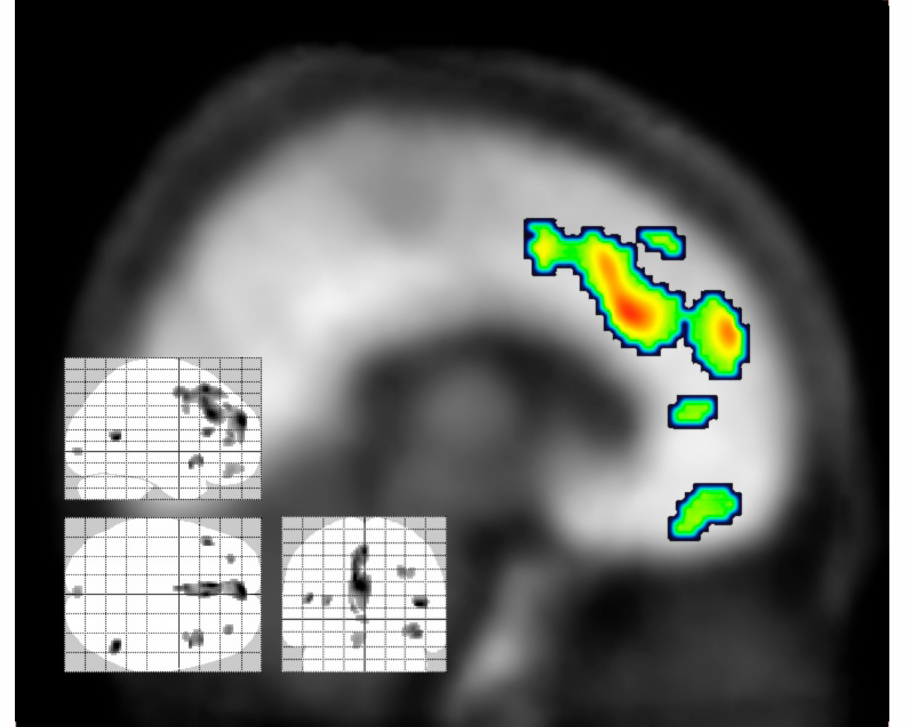
Figure 6. Inverse Correlation of 5D-ASC Global Scale scores and [ 18 F]-altanserin ( 39 ) apparent distribu- tion volume [DV’]. Results of a voxel based correlation analysis ( ∆ 5D-ASC global vs. ∆ DV’, threshold p < 0.005, uncorrected) using Statistical Parametric Mapping [105]. Reproduced with